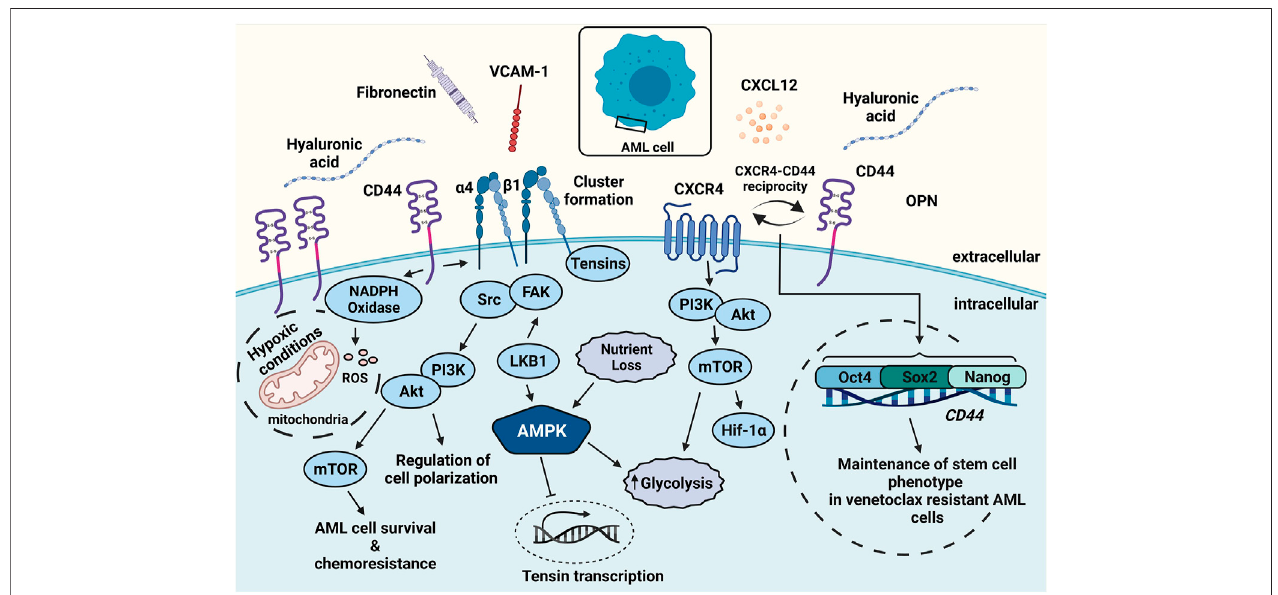
FIGURE 2 | Leukemic cell survival can be augmented by adhesion and metabolic components. AML cells express high amounts of CD44, CXCR4, and α 4 β 1. Ligands such as HA, CXCL12, and VCAM-1 secreted by stromal cells activate the receptors and render chemoresistance. CD44-mediated activation and clustering of α 4 β 1 leads to adhesive hubs and promotes mTOR activity. CXCL12 interaction with CXCR4 can be followed by enhanced glycolysis. CXCR4 interaction with CD44 confers a cancer stem cell phenotype via Oct4, Sox2, and Nanog expression. Elevated CD44 expression increases ROS levels via NADPH oxidase and further promotes malignancy. Abbreviations: FAK, focal adhesion